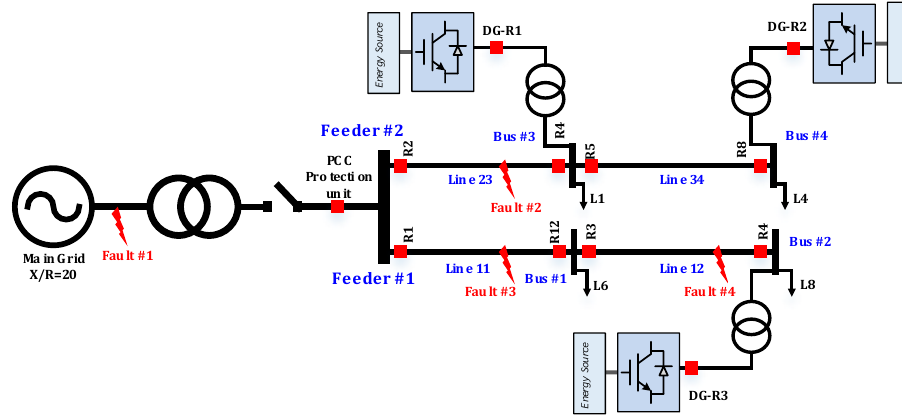
Figure 9. Configuration of AC MG test system and fault